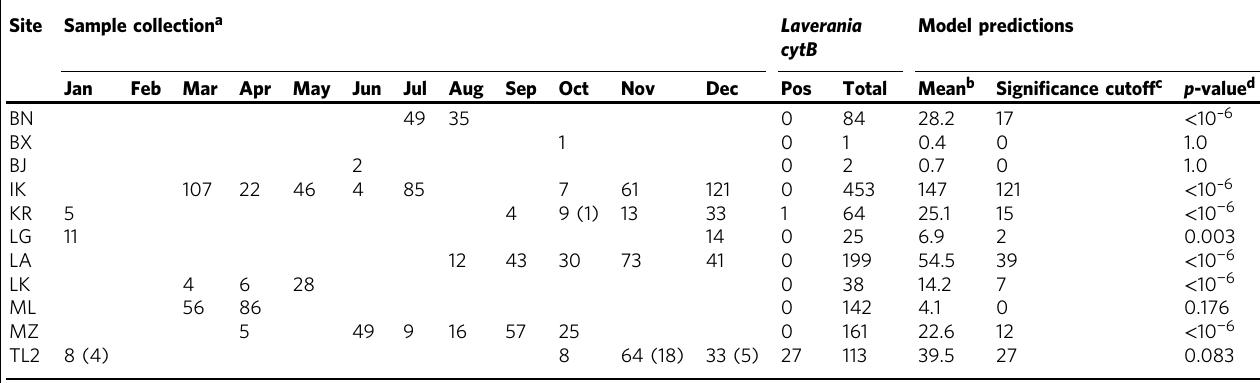
Table 2 Seasonal variation in parasite prevalence does not explain the geographic restriction of bonobo malaria Site Sample collection